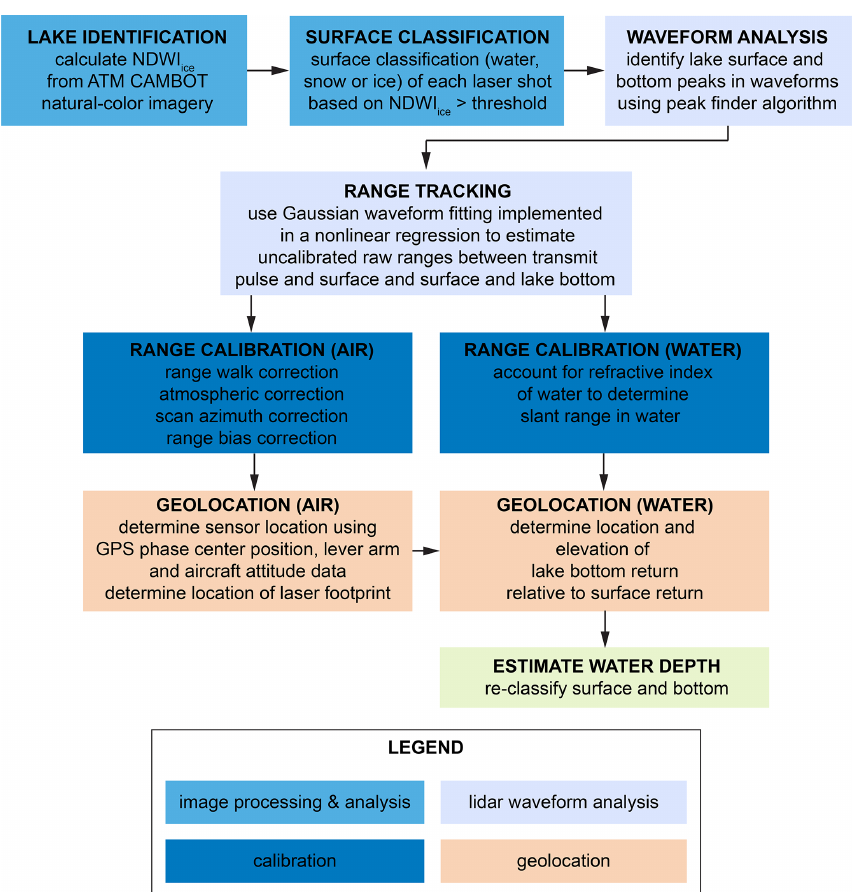
Figure B3. Flow diagram summarizing both the image-based processing steps discussed in this section and the process of deriving geolocated water depth estimates from lidar data discussed in Sect.